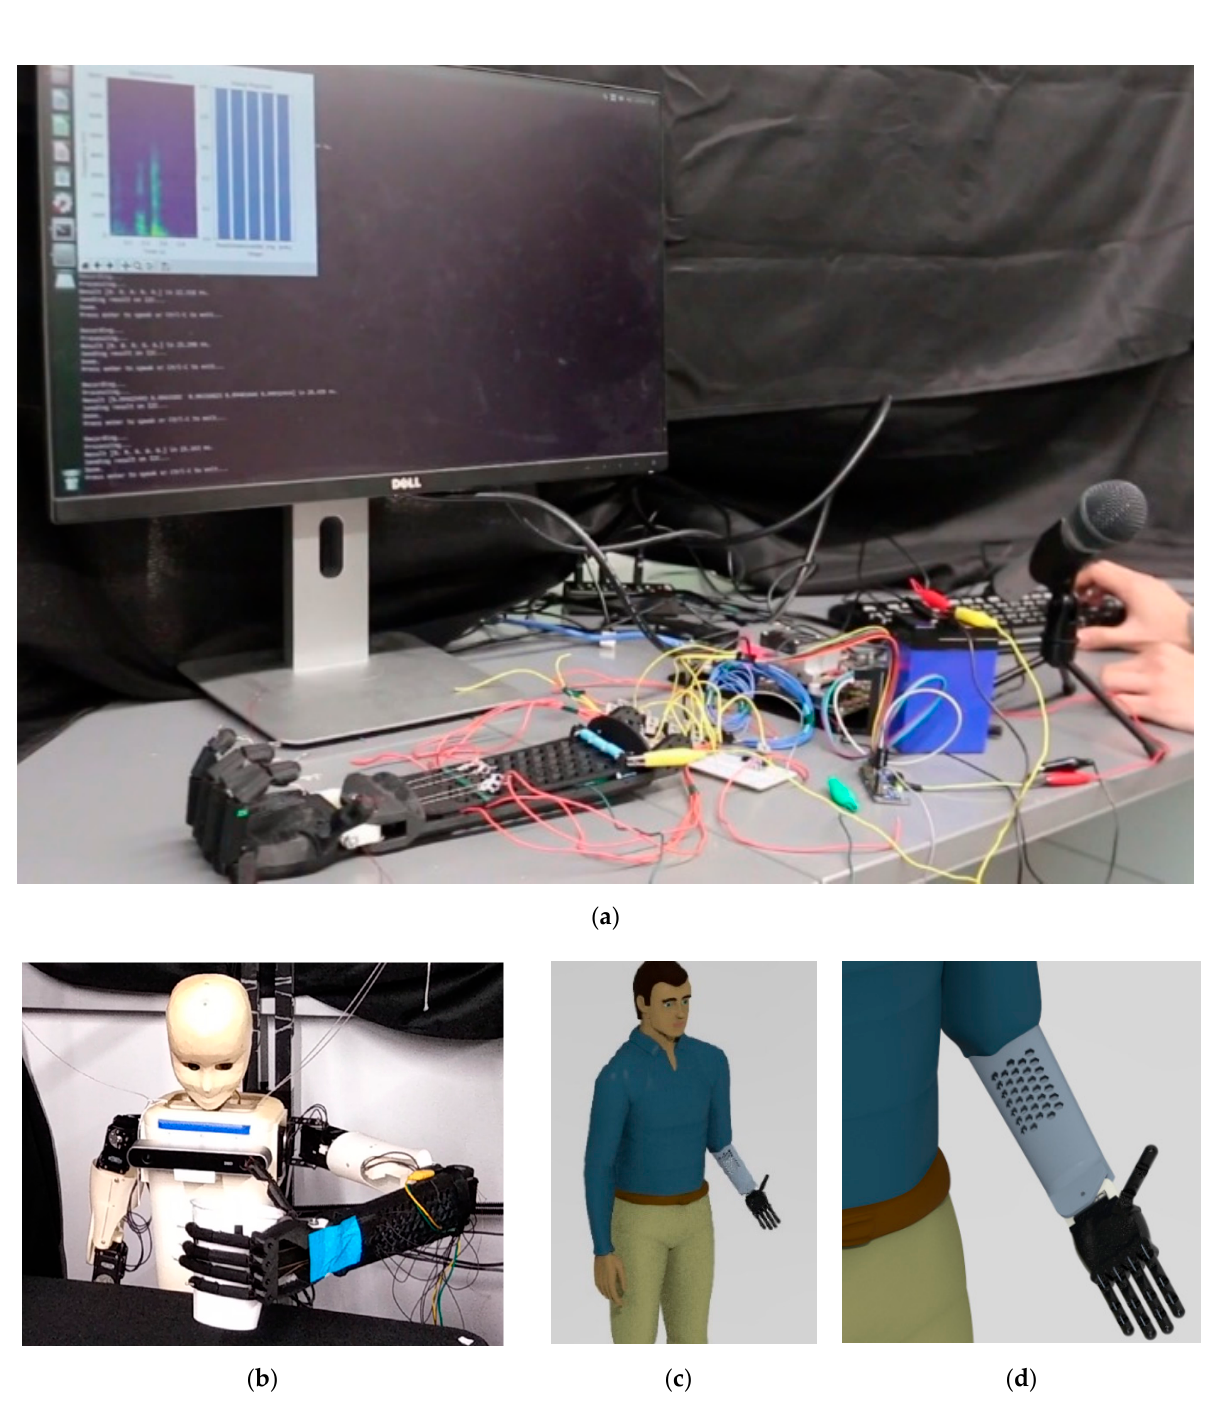
Figure 14. Future work concepts use in conjunction with: ( a ) speech control interface, ( b ) social robot, ( c ) prosthetic application and ( d ) enlarged view showing similar sizing of the current design to the adult hand.